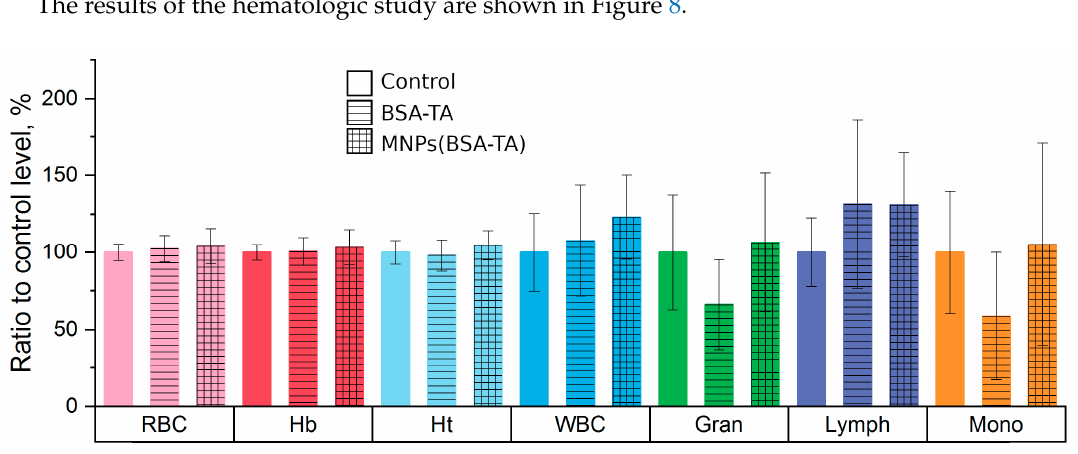
Figure 8. Effect of microcarriers on hematological parameters (data are presented as per cent of control group level). RBC—red blood cells, Hb—hemoglobin, Ht—hematocrit, WBC—white blood cells, Gran—granulocytes, Lymph—lymphocytes, Mono—monocytes. Both types of carriers did not affect levels of hemoglobin, red and white blood cells.